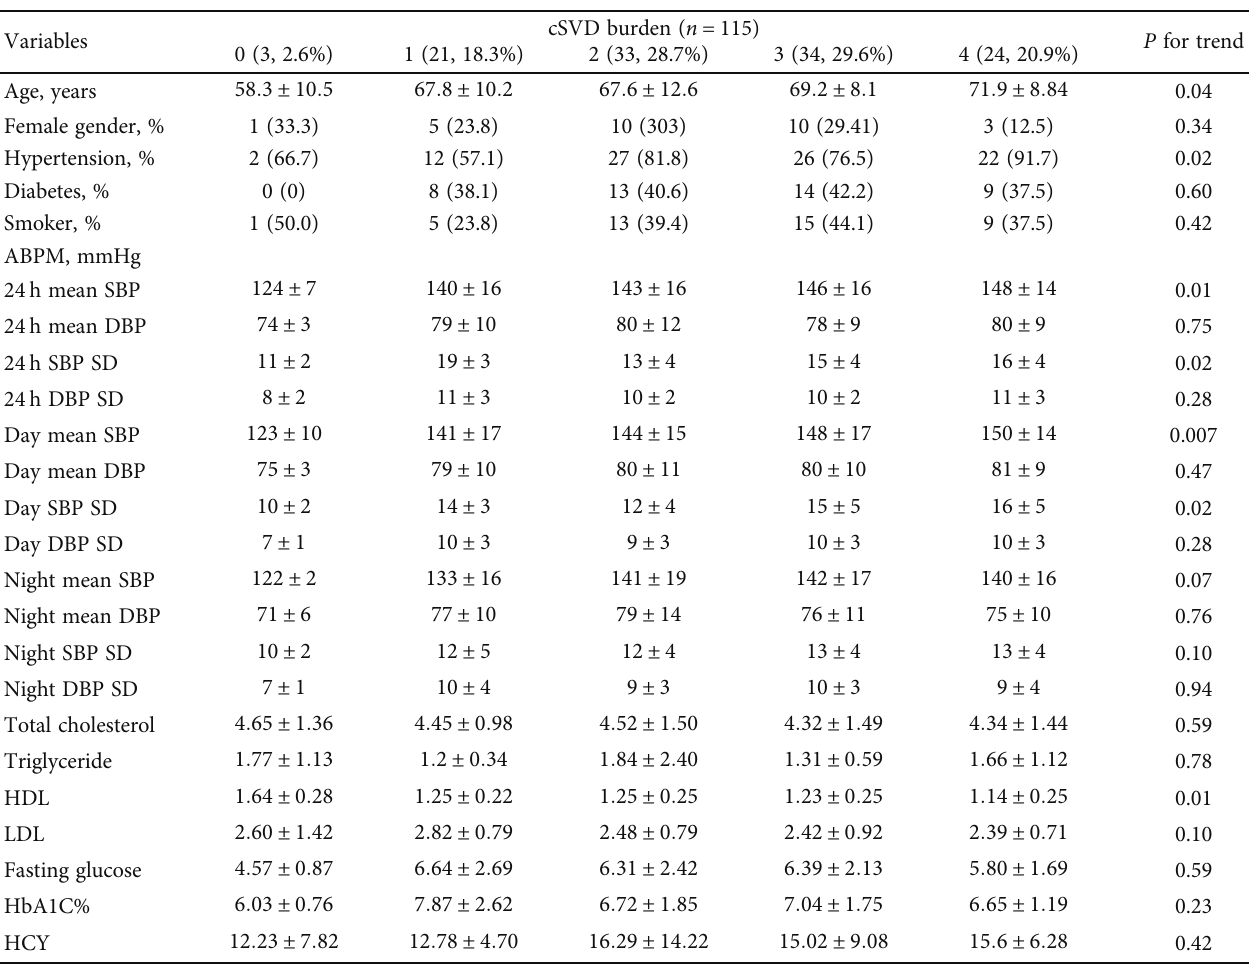
Table 1: Characteristics of the study participants.